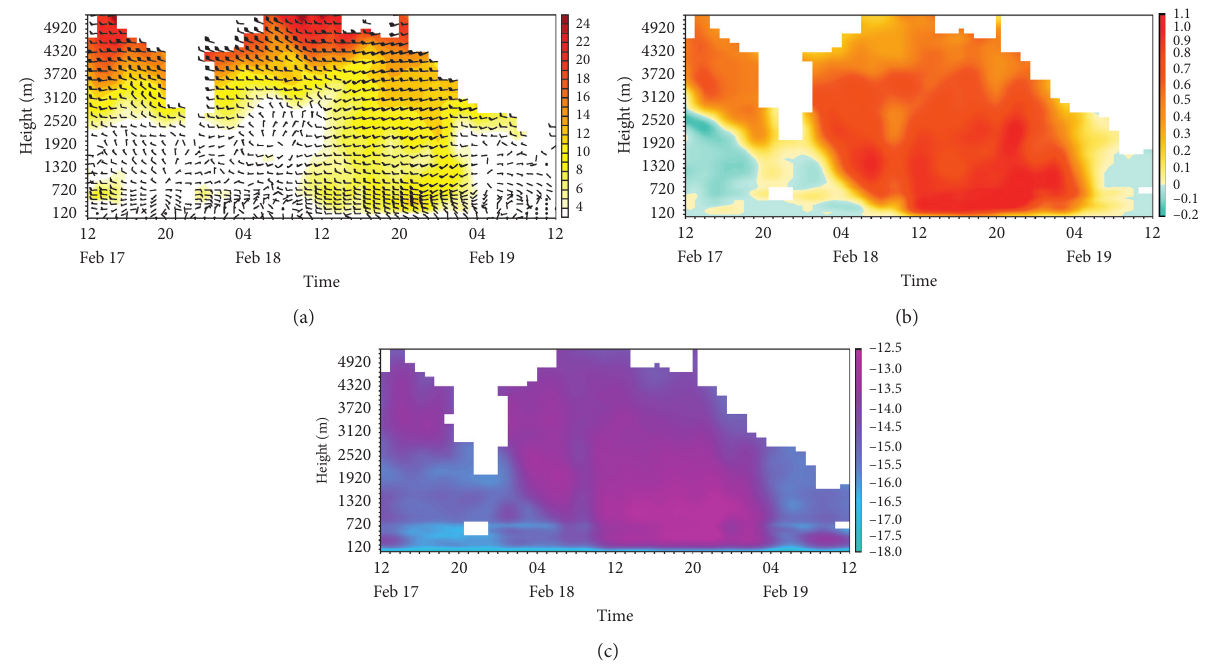
Figure 6: Time-height profile of radar wind profiler data: (a) horizontal wind (shadow; unit, ms − 1 ), (b) vertical velocity (shadow; unit, ms − 1 ), and (c) natural logarithm of the atmospheric refractive index structure constant